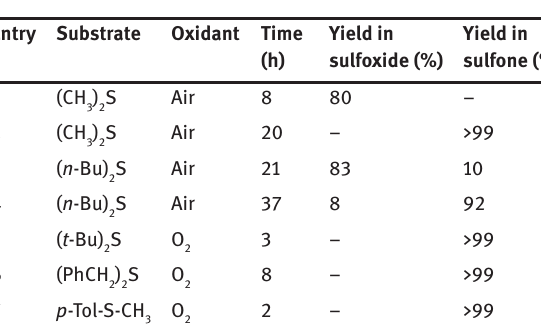
Table 1: Oxidation of disubstituted sulphides catalysed by Co-Cat under Mukaiyama’s